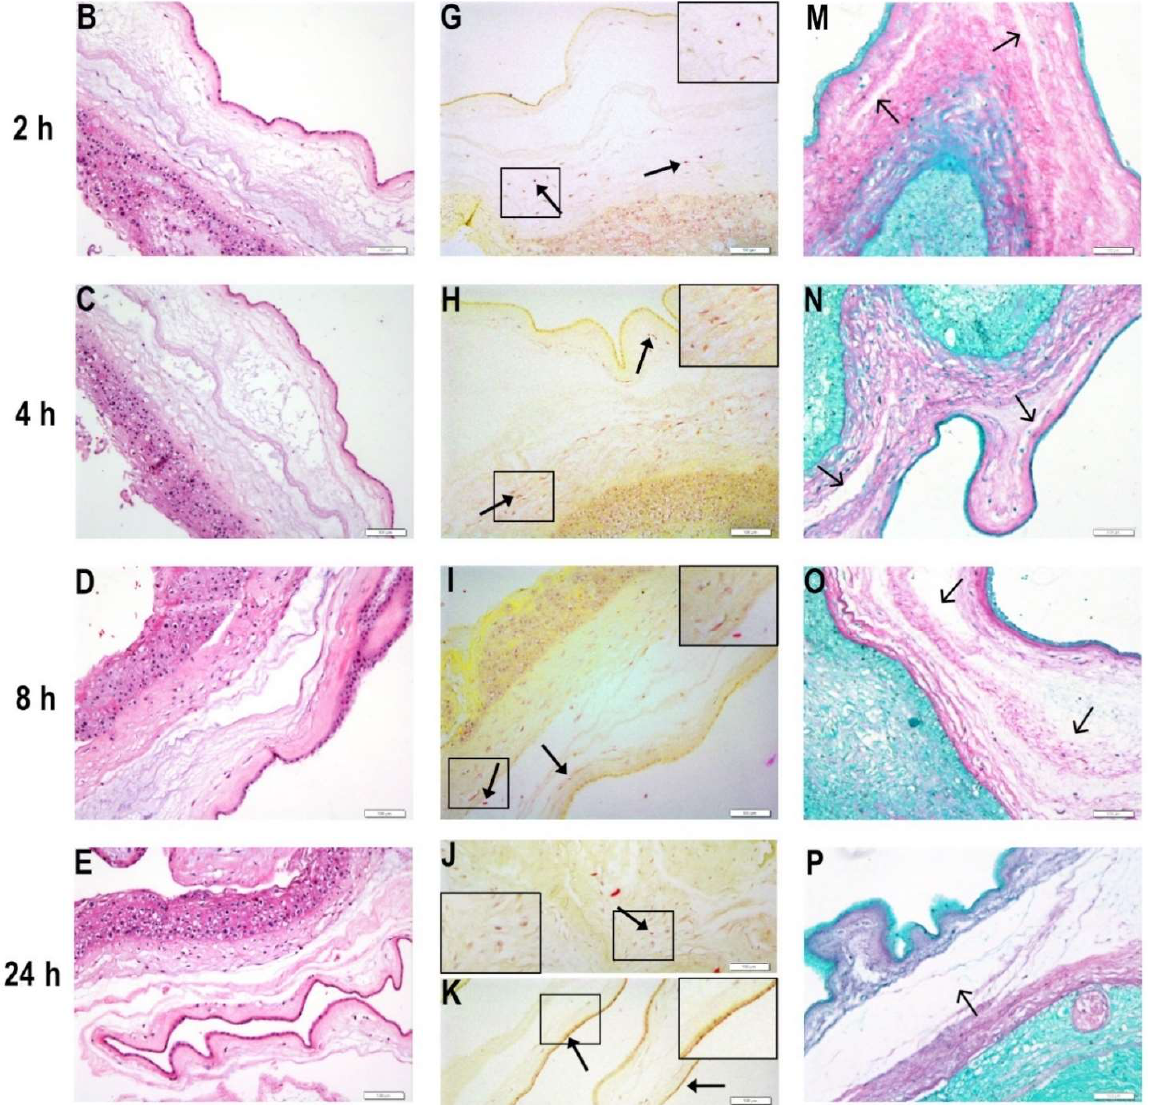
Figure 1. Kinetic time follow-up of choriodecidual infection by Escherichia coli . The histological examination of E. coli -infected membranes was analyzed 2, 4, 8, and 24 h after tissue inoculation to evaluate the mechanical damage and bacteria migratory capacity through the CHD and AMN layers. Left panel ( A – E ): Fetal membranes were stained with hematoxylin and eosin. Middle panel ( F – K ): Modified Gram staining. The closed arrowheads show bacterial accumulation. Panel amplification is shown in the square. Right panel ( L – P ): Collagen fibers were stained with Sirius red to observe zones with collagen degradation. The open arrowheads show zones with extracellular matrix degradation. Scale bar at 100 µ m is shown at bottom right in each picture. Representative photographs from five independent experiments are shown. AE: amniotic epithelium. AMN: amnion. BL: Basal layer. CHD: choriodecidua. CL: Compact layer. FL: Fibroblastic layer. TB: